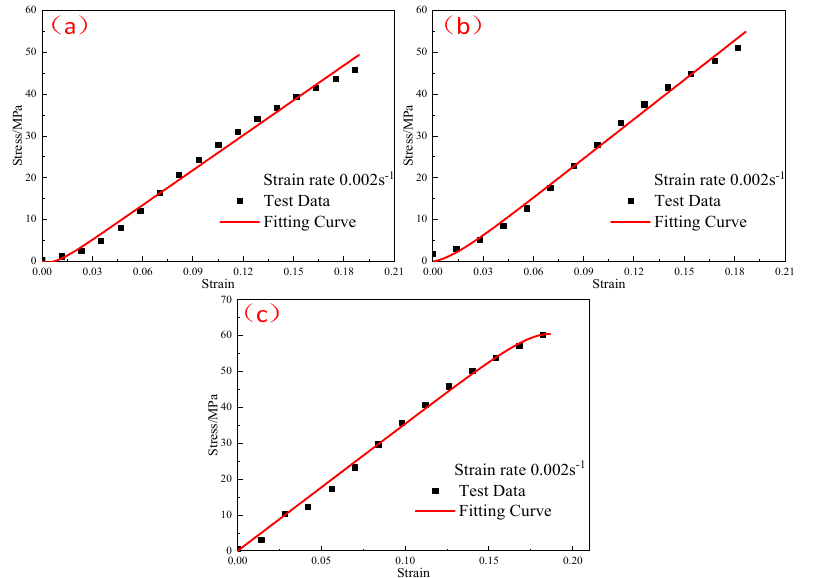
Figure 18. The results of the ZWT constitutive model fitting at low strain rates and different temperatures: ( a ) − 20 °C; ( b ) − 30 °C; ( c ) − 40 °C. The elastic moduli 0 E and 1 E of the linear spring obtained from the quasi-static and relaxation time